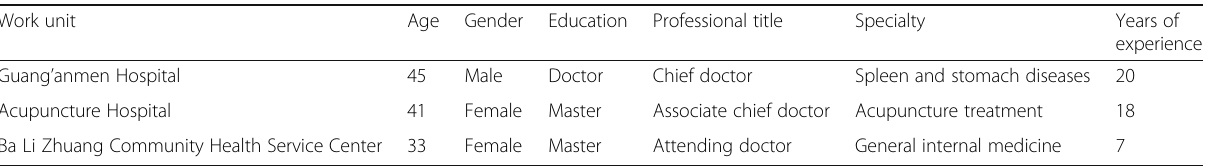
Table 2 Sample Characteristics: Doctors (N = 3) Work